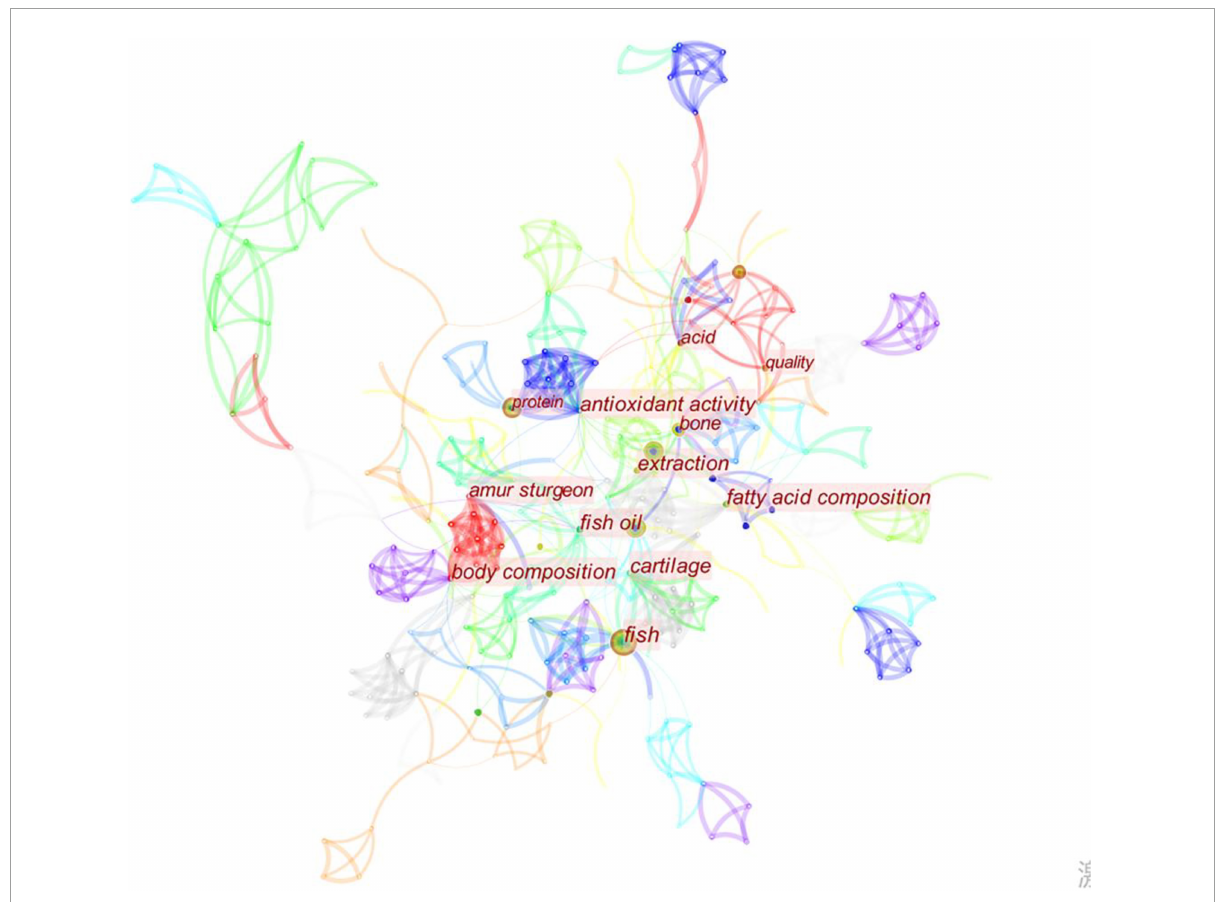
FIGURE5 Keyword node map of deep sturgeon